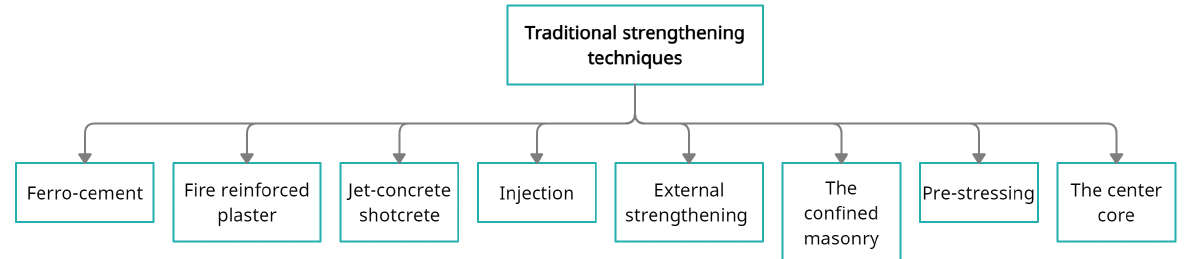
Figure 2. Traditional strengthening techniques of masonry structures